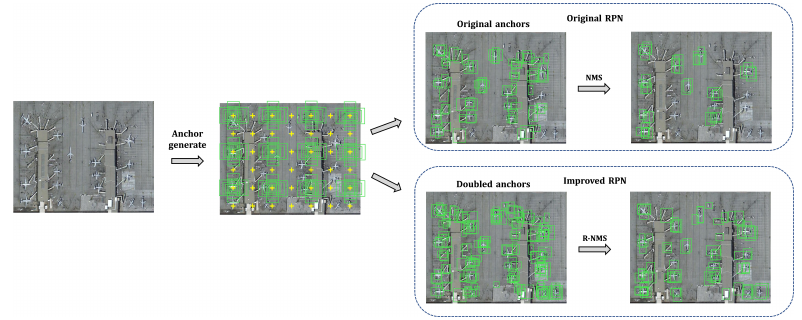
Figure 4. The proposals generated by RPN and improved